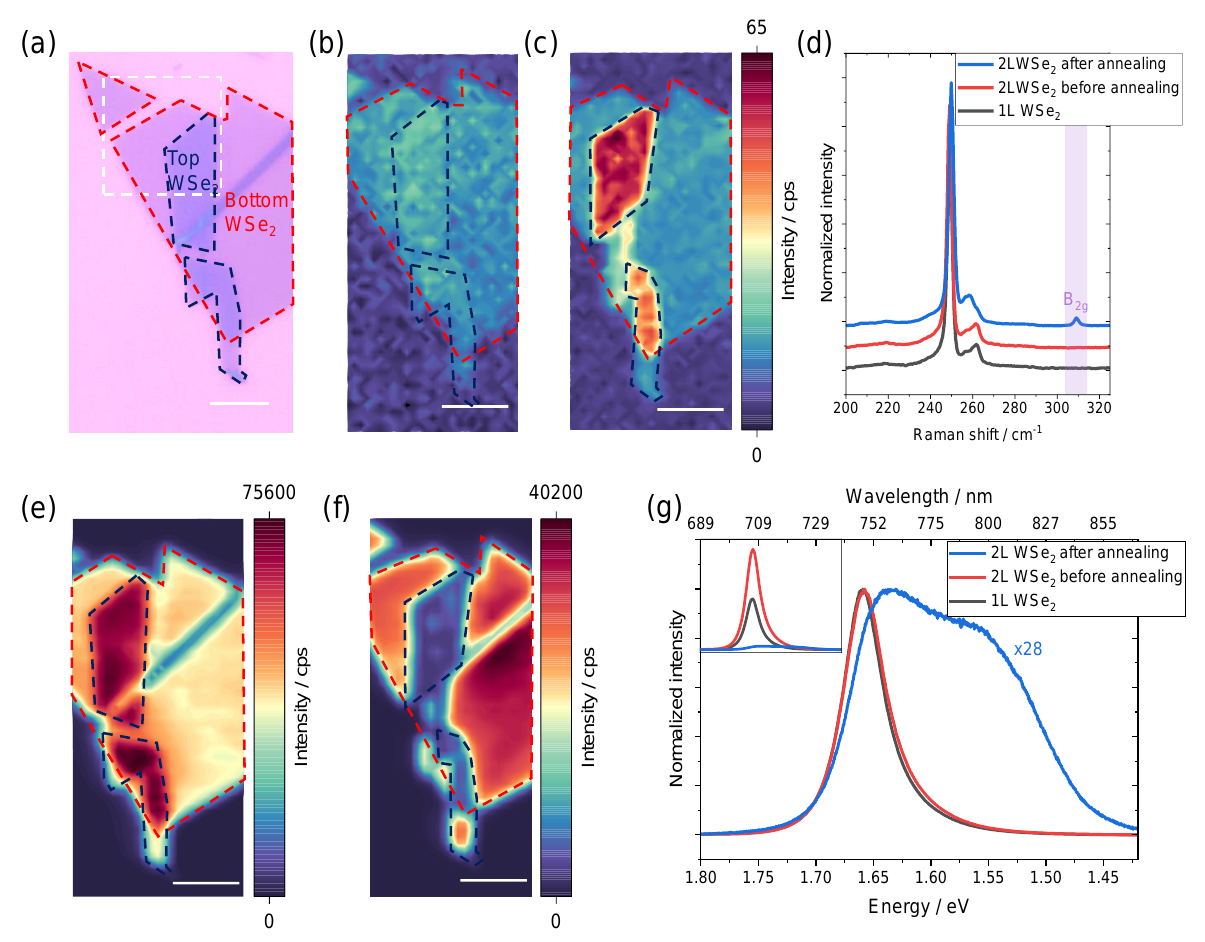
Figure 2. Raman and PL measurements of monolayer and bilayer WSe 2 . ( a ) Optical microscope image of monolayer and bilayer WSe 2 . Raman intensity map of the WSe 2 B 2 g peak (304–314 cm − 1 ) ( b ) before and ( c ) after annealing. ( b , c ) share the same color scale. ( d ) Raman spectra of